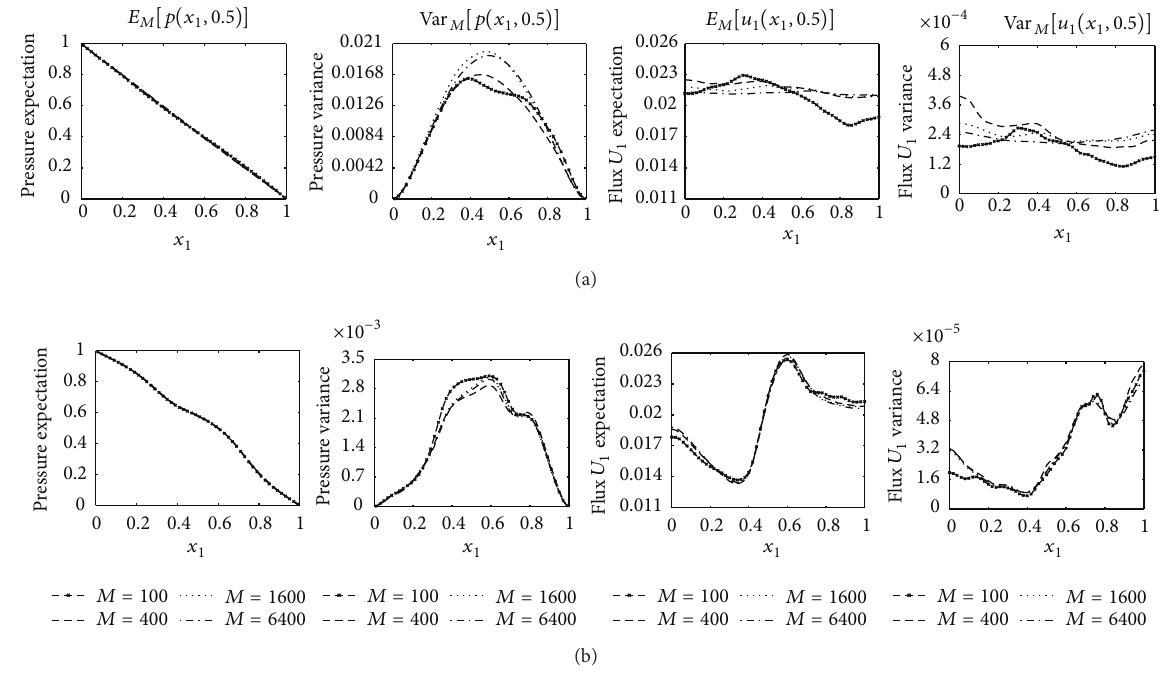
Figure 6: Profiles obtained with SGS-MC of moments of pressures and fluxes for unconditional field 𝑁 𝑚 = 0 (a) and conditional field with = 30 (b). 𝑁 𝑚